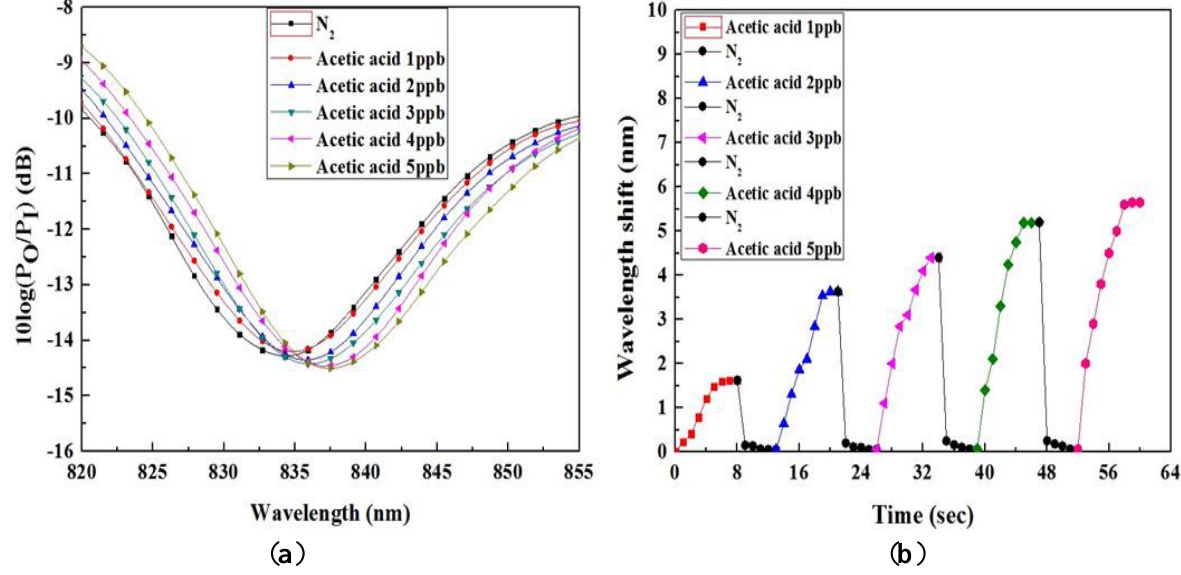
Figure 6. Spectrum analyzes results of after acetic acid gas exposure: ( a ) variations in resonance wavelength shift; and ( b ) saturation and recovery